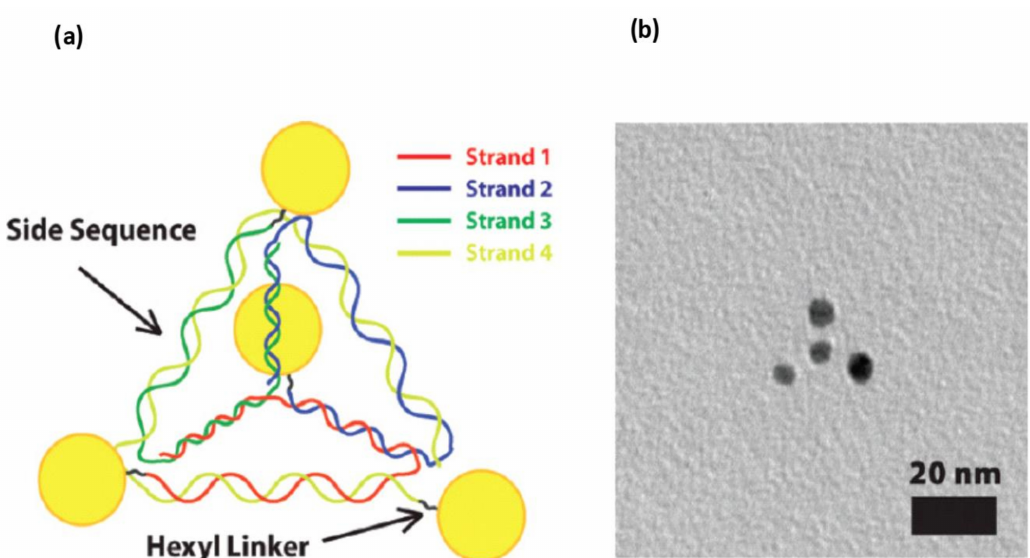
Figure 40. ( a ) The Free-DNA ends at every point of reference could be altered to include GNP with a linker sequence; ( b ) a single DNA pyramid Au NP microgram with four Au NPs visible in black circles: Reprinted with reference authorisa- tion [249], Copyright 2009, ACS.